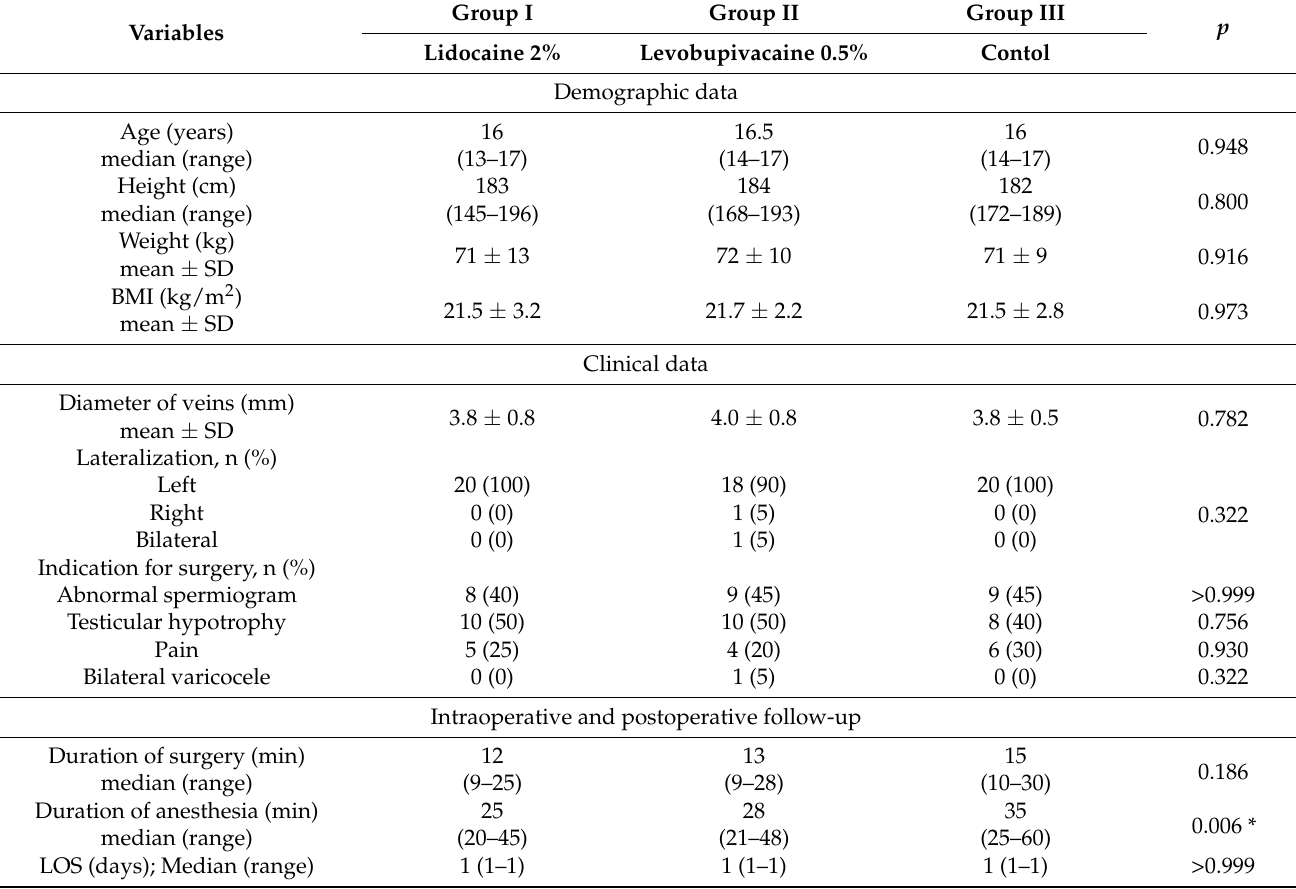
Table 1. Demographic, clinical and follow-up data of the patients.